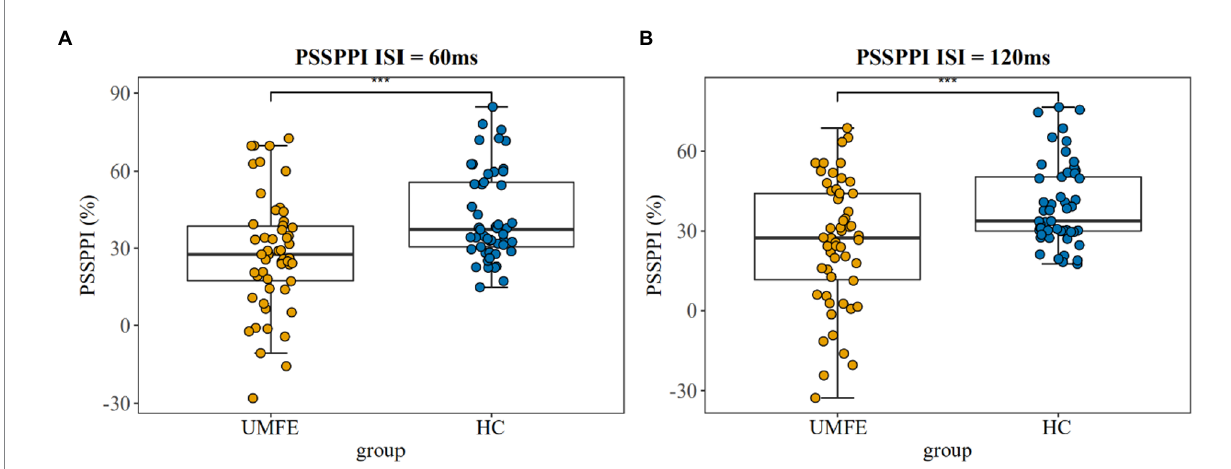
FIGURE 2 Prepulse Inhibition of perceptual space separation at 60 ms intervals (Left); Prepulse Inhibition of perceptual space separation at 120 ms intervals (Right). UMFE: unmedicated first-episode schizophrenia, HC: healthy control. *** p value <0.001.